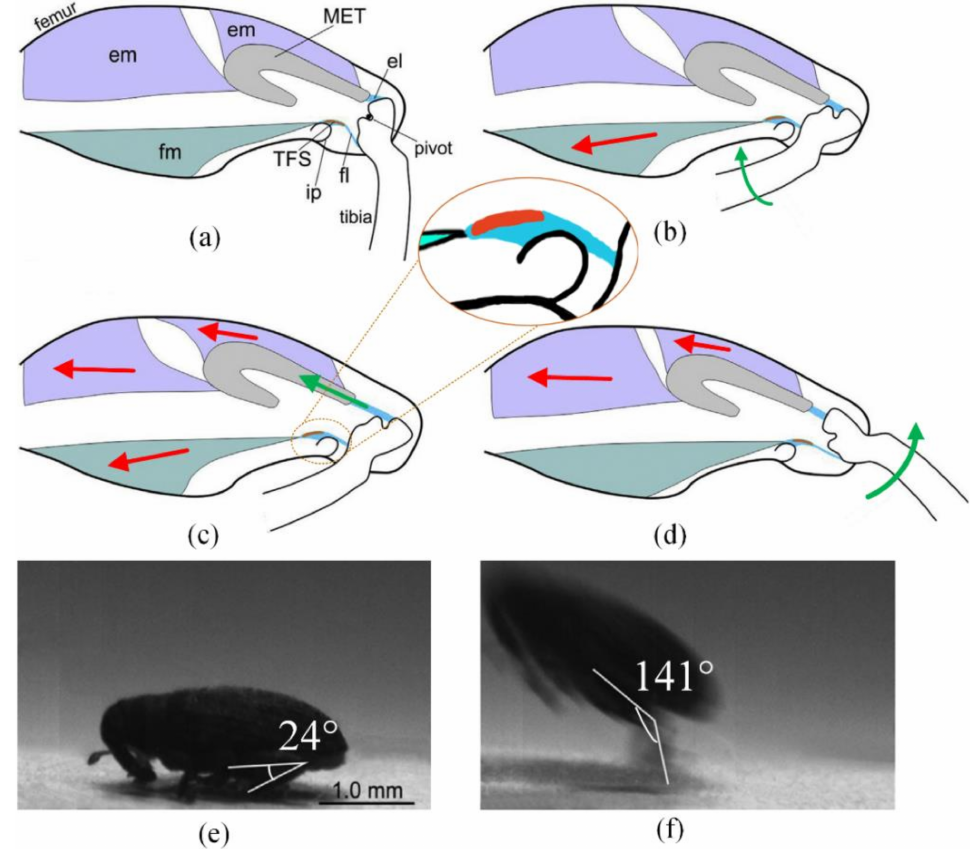
Figure 1. Working period ( a – d ) with initial and terminal phases ( e – f ) of weevil’s jumping mechanism. Red arrays stand for forces in muscles, green arrays stand for motions. Abbreviations: em, extensor muscle; el, extensor ligament; fm, flexor muscle; fl, flexor ligament; ip, internal protrusion; MET, metafemoral extensor tendon; TFS, tibial flexor sclerite © 2018 Elsevier Ltd. All rights reserved